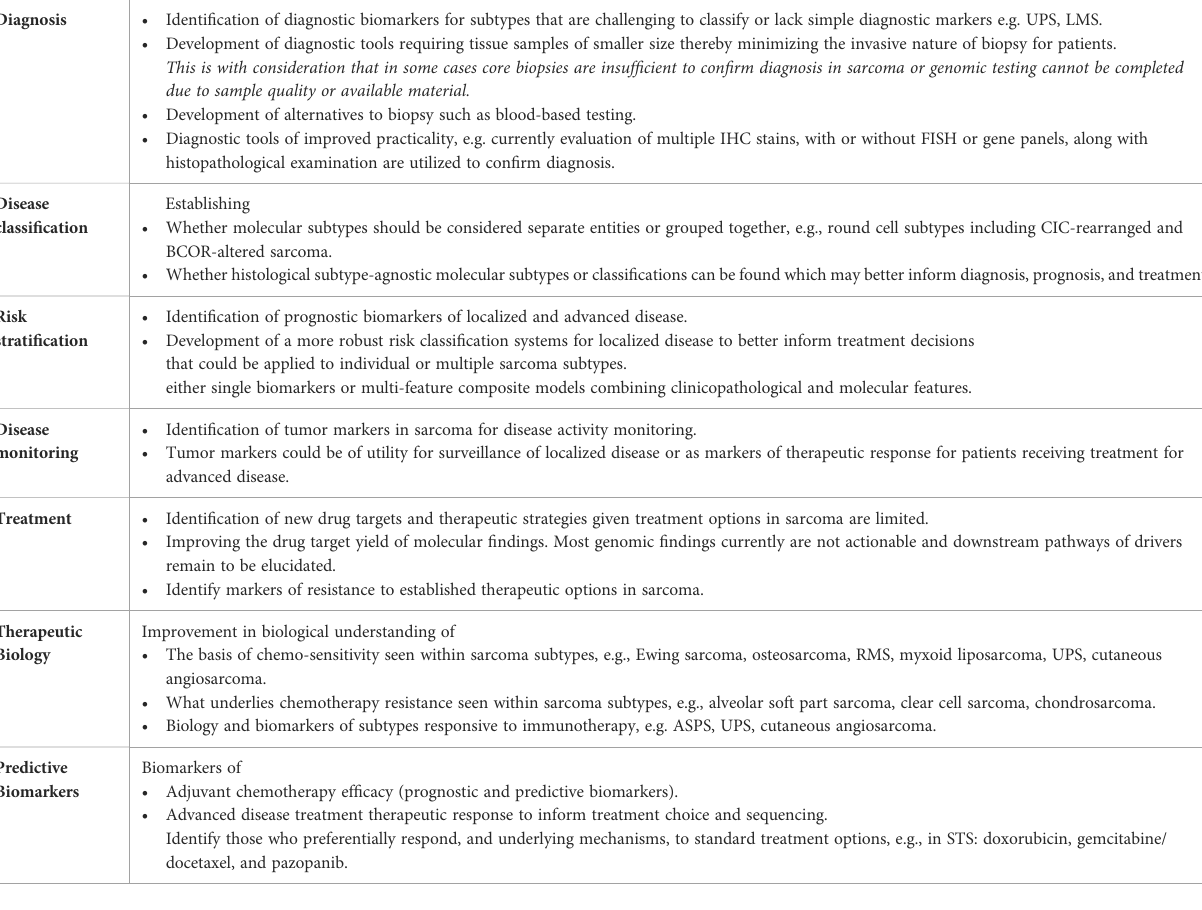
TABLE 2 Unmet needs and questions in sarcoma that may be possible to address with proteomics.